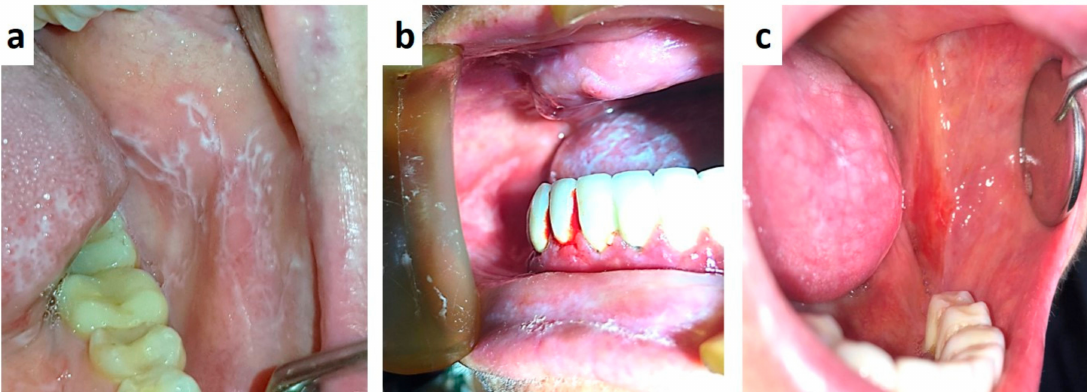
Figure 9. ( a – c ) Reticular white lesions of the cheek mucosa as early manifestation of Lichen Planus ( a ). Diffuse white lesions of the tongue, lip and adherent gingiva, eritro-leukoplakia of the cheek mucosa and diffuse autoimmune gingivitis in the mandible in patient with severe disease still untreated ( b ). Eritroplakia of the cheek detected during follow-up in a patient with Lichen Planus of long-lasting duration ( c